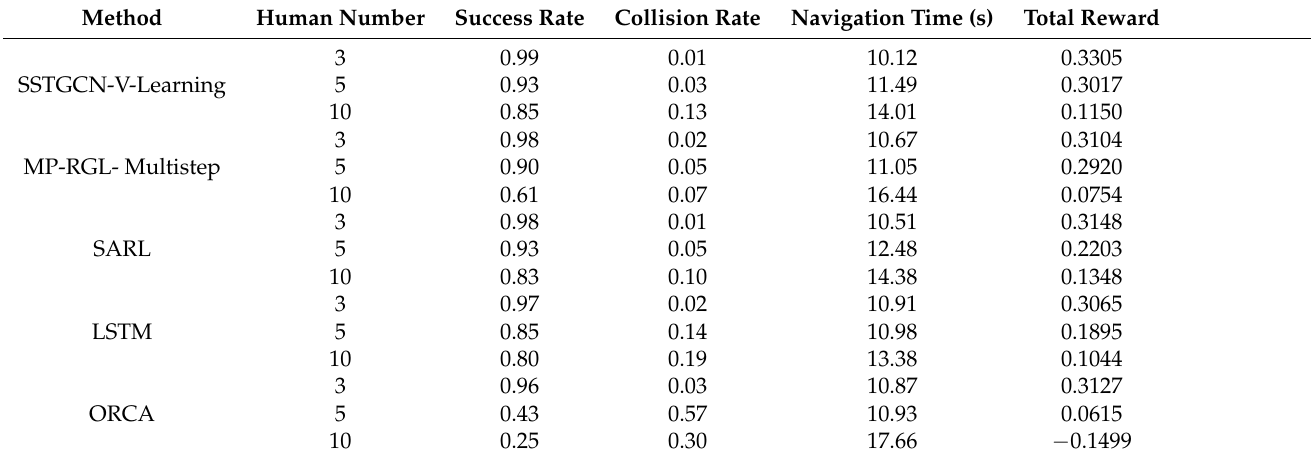
Table 2. Performance comprison among the crowd navigation algorithms.